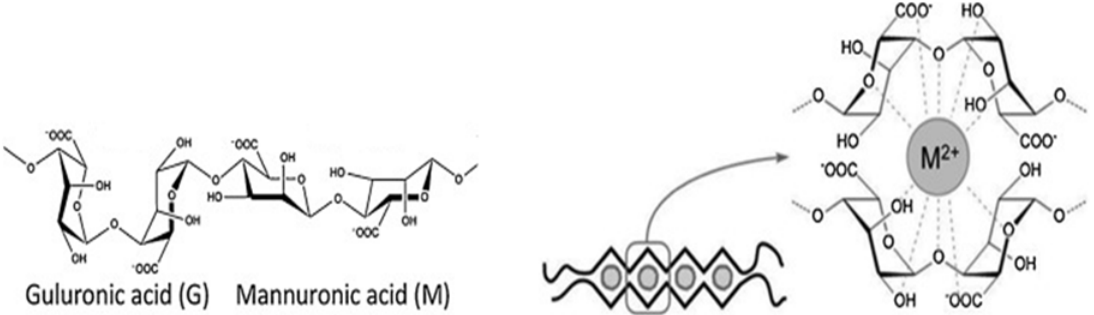
Figure 4. Structure of alginate and “egg-box” model representing alginate organization in the presence of multivalent cations.